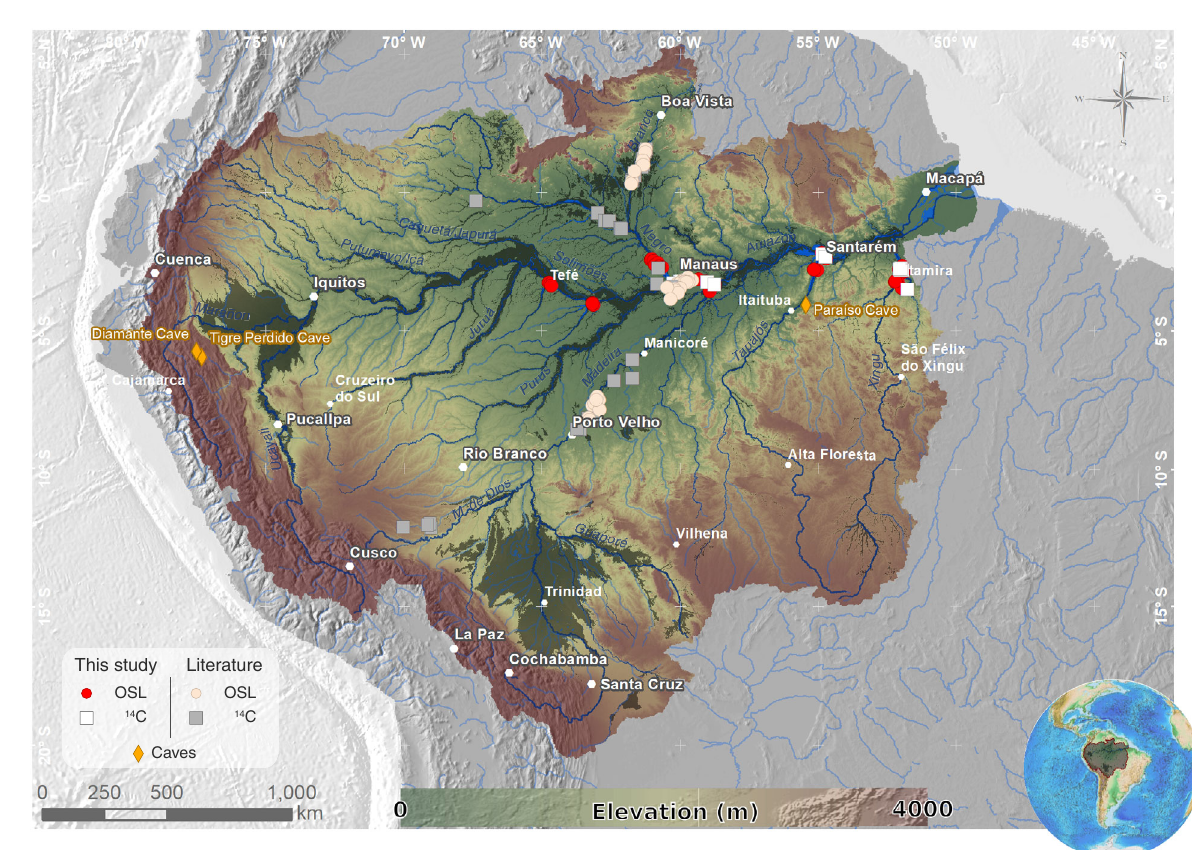
Fig. 1 | Sites with OSL and radiocarbon( 14 C) ages from substrates ofseasonally fl oodedareas(dark green shade) acrossthe AmazonRiver basin. Sitessampled in this study can be observed in more detail in Fig. 2. Geographical coordinates of